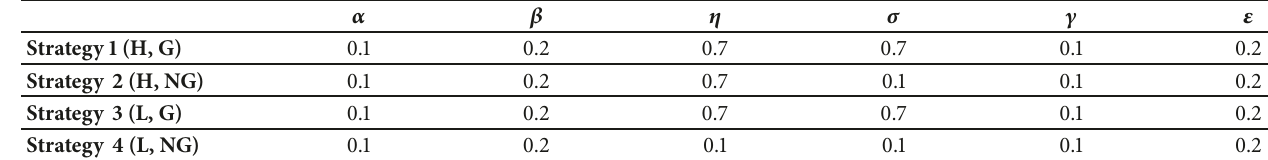
Table 4: Parameters assignment of